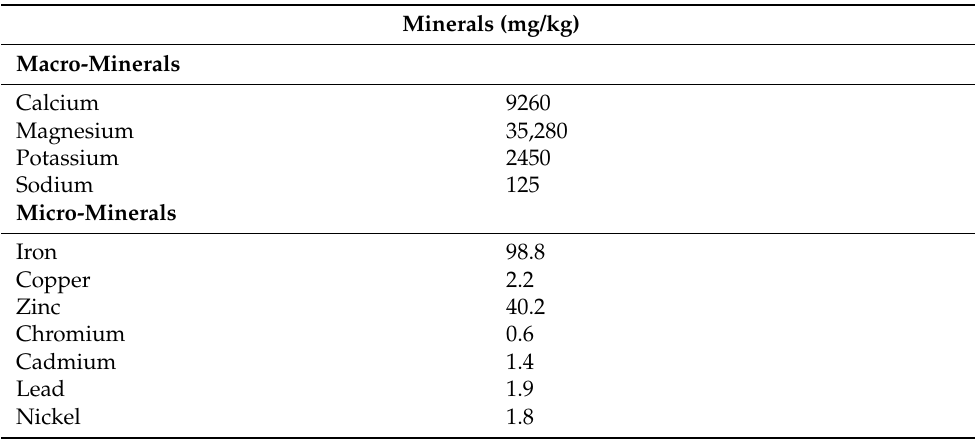
Table 1. Mineral composition of W. coagulans